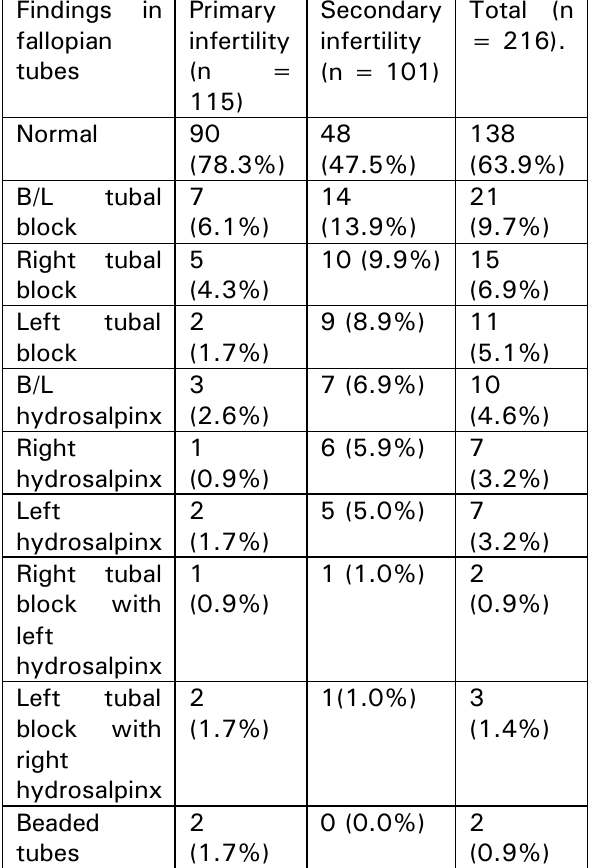
Figure 4: B/L hydrosalpinx